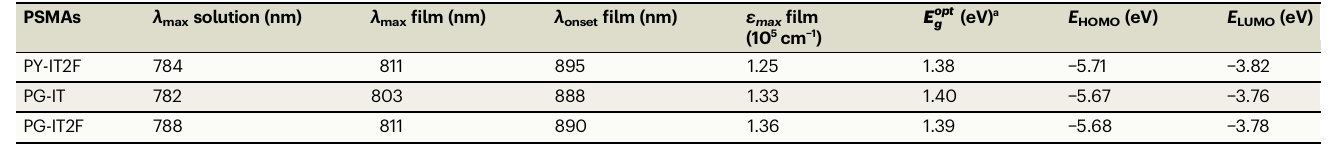
Table 1 | Physicochemical properties of PY-IT2F, PG-IT, and PG-IT2F